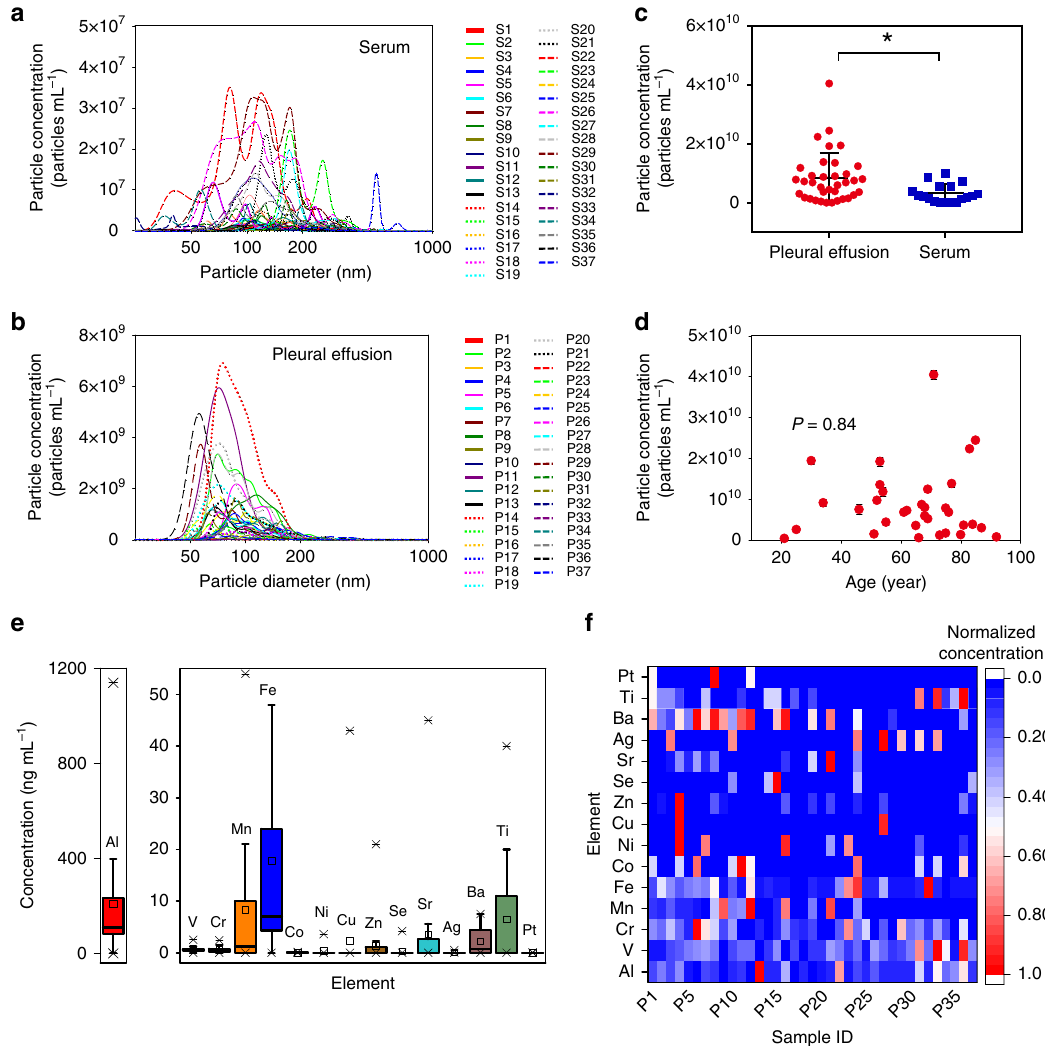
Fig. 1 Concentration, size distribution, biological effect, and elemental fi ngerprints of NPs in human serum and pleural effusion. a Concentration and size distribution of NPs in human serum samples. b Concentration and size distribution of NPs in human PE samples. c Comparison of particle concentrations in serum and PE. * P = 0.0002 (unpaired Student ’ s two-tailed t test). Error bars represent mean ± s.d. ( n = 37). d Correlation of particle concentration in PE with the age. P = 0.84 ( F test in linear regression analysis; n = 37). e – f Elemental concentration ranges e and heating map f of normalized elemental fi ngerprints of the NPs extracted from 37 human PE samples ( n = 37). In e bounds of the box spans from 25% to 75% percentile, center line represents median, and whiskers visualize 5% and 95% of the data points. The high-abundance elements in organisms (e.g., C, H, O, N, S, P, Na, K, Ca, Mg, and Cl) are not shown. Source data are provided as a Source Data fi